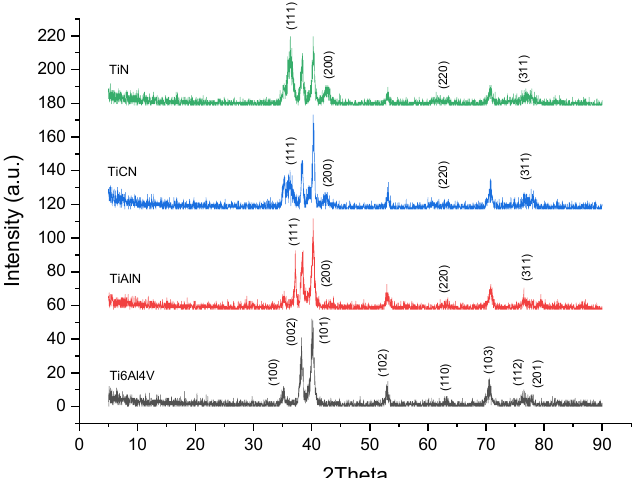
Figure 6. X-ray diffraction analysis patterns of the uncoated Ti alloy and TiN, TiAlN, TiCN films deposited on